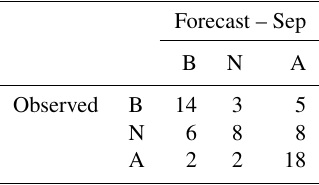
Table 2. Stat-PCR and Stat-Dyn forecast model performance metrics. Forecast Retained predictors PC1 PC2 Statistical approach 1 Sep Aug SM